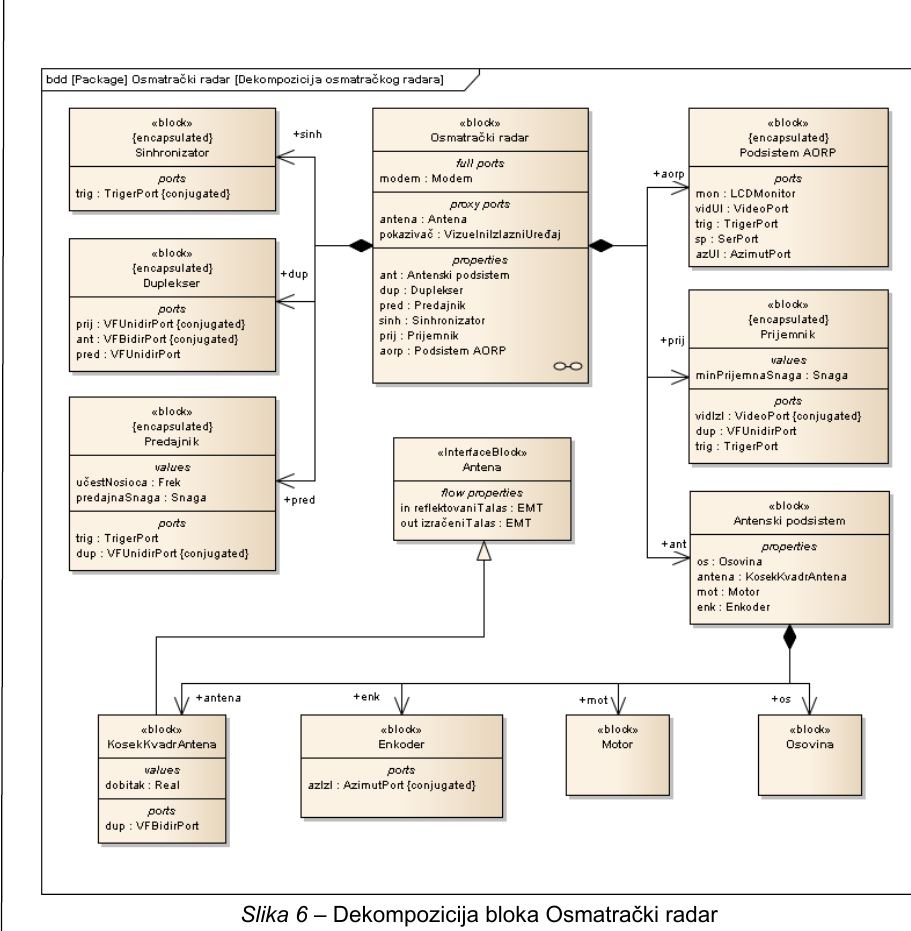
Рис . 6 – Декомпозиция блока радиолокационной станции кругового обзора Figure 6 – Decomposition of the Osmatra č ki radar (surveillance radar) block Parametarski